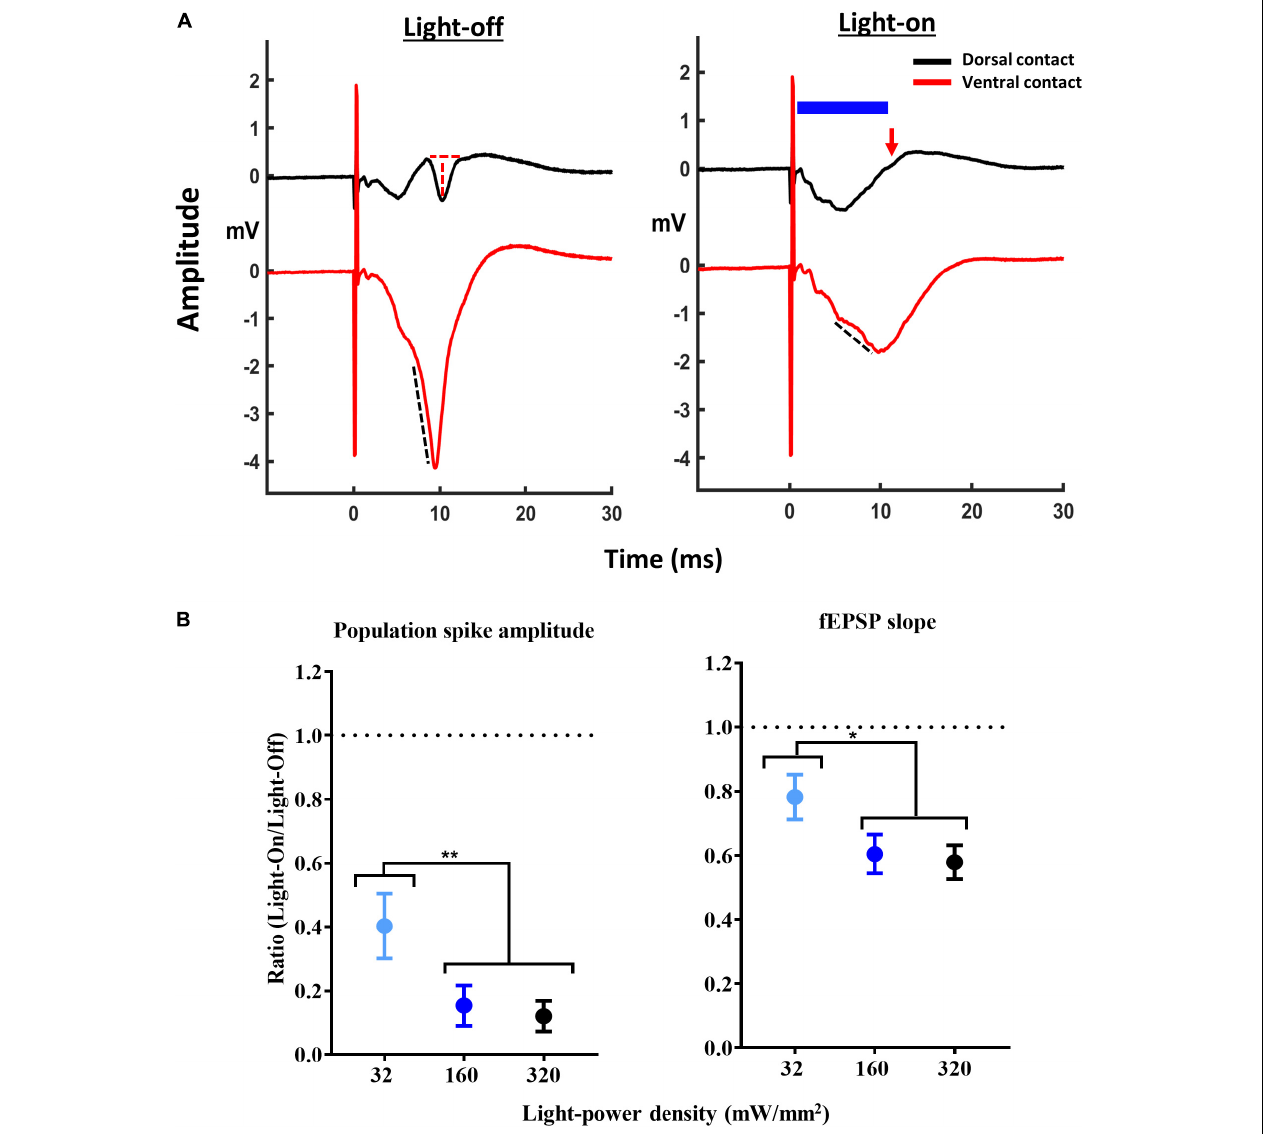
FIGURE 2 | Attenuation of CA1 EPs with activation of GtACR2. (A) Representative traces of CA1 EPs without (light-off) and with (light-on) delivery of 10 ms light-pulse (blue bar) at 160 mW/mm 2 , 1 ms after the electrical stimulation at dorsal contact measuring population spike (PS) amplitude (red dotted line and red arrow indicating complete suppression of PS) and ventral contact measuring fEPSP slope (black dotted line). (B) Increasing the light-power density resulted in a decrease of the PS amplitude ( n = 10) and fEPSP slope ( n = 8). * p ≤ 0.05 and ** p <